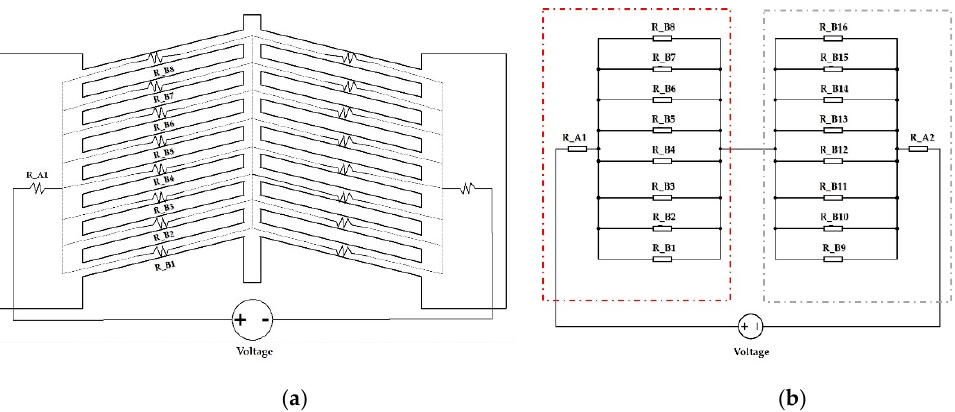
Figure 5. ( a ) Resistive volumetric and ( b ) electric models of chevron actuator of eight pairs of beams. Resistances of each beam have the same value ( R B1 = R B2 = . . . = R B8 = R B ), simplified